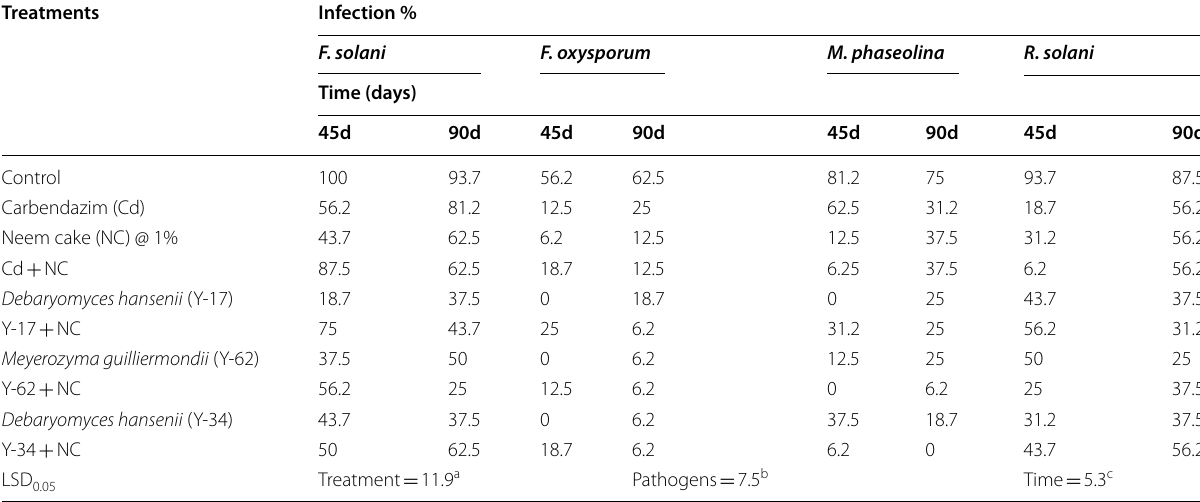
a Mean values for treatment in column showing differences greater than LSD values are significantly different at p < 0.05 b Mean values for pathogen in rows showing differences greater than LSD values are significantly different at p < 0.05 c Mean values for time in rows showing differences greater than LSD values are significantly different at p < 0.05